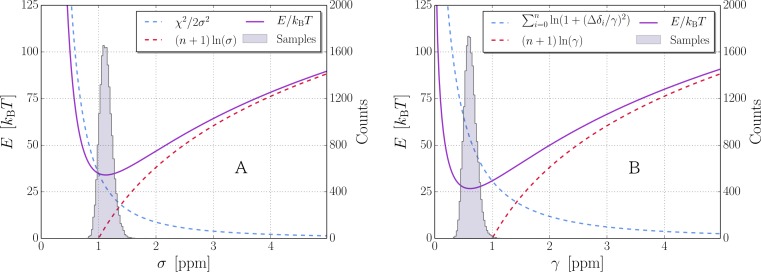
Uncertainty sampling with Gaussian and Cauchy distributions.Sampling of σ and γ, using Jeffrey’s priors, for Cα-chemical shifts of Protein G. nCα = 54 and \documentclass[12pt]{minimal}
\usepackage{amsmath}
\usepackage{wasysym}
\usepackage{amsfonts}
\usepackage{amssymb}
\usepackage{amsbsy}
\usepackage{upgreek}
\usepackage{mathrsfs}
\setlength{\oddsidemargin}{-69pt}
\begin{document}
}{}${\chi }_{{C}_{\alpha }}^{2}=69.7~{\mathrm{ppm}}^{2}$\end{document}χCα2=69.7ppm2. (A) Gaussian distribution, (B) Cauchy distribution.